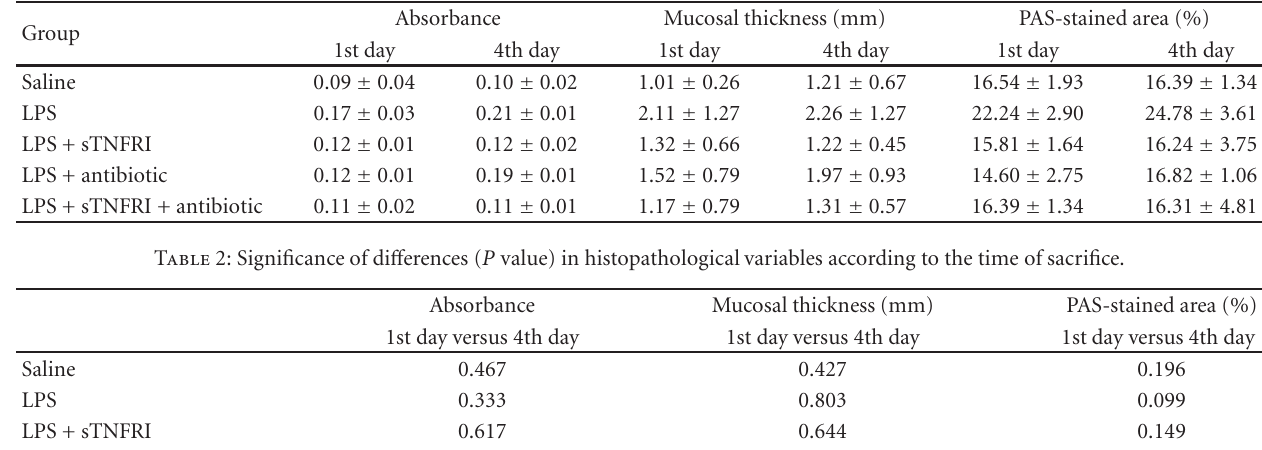
Table 1: Histopathological changes in nasal mucosa (mean ± SD).